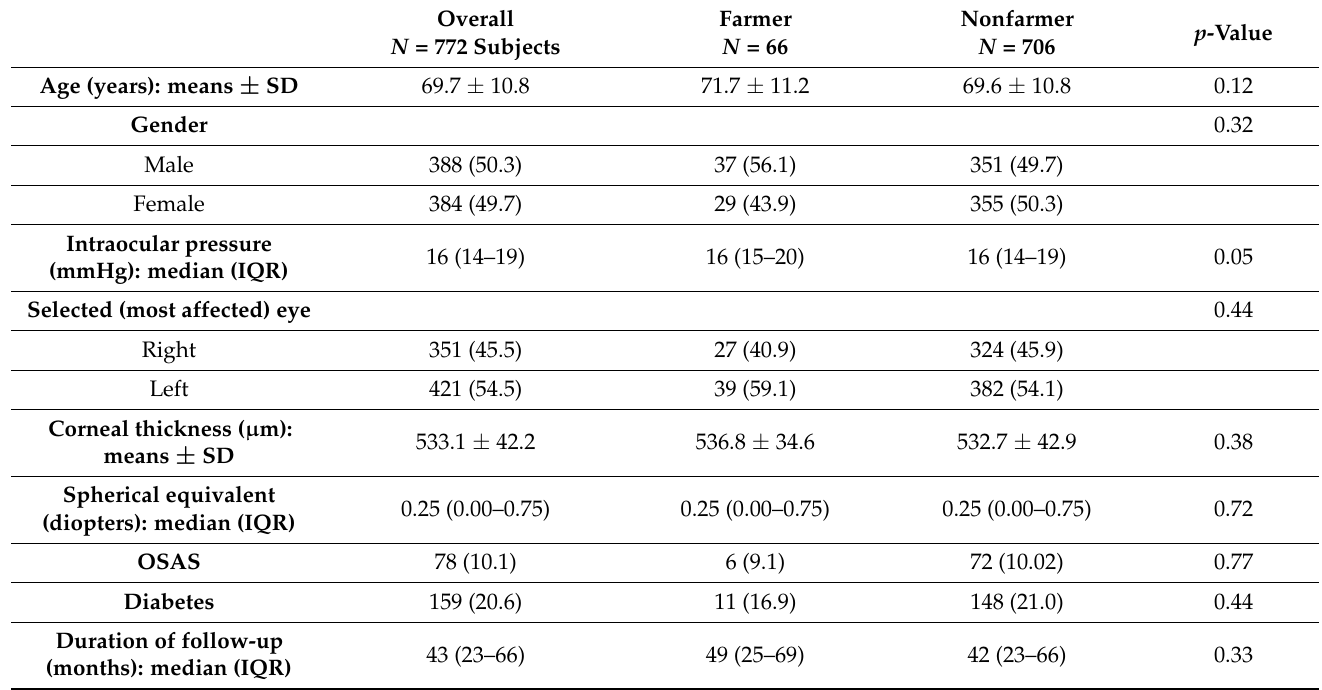
Table 1. Characteristics of patients in farmer and non-farmer groups.